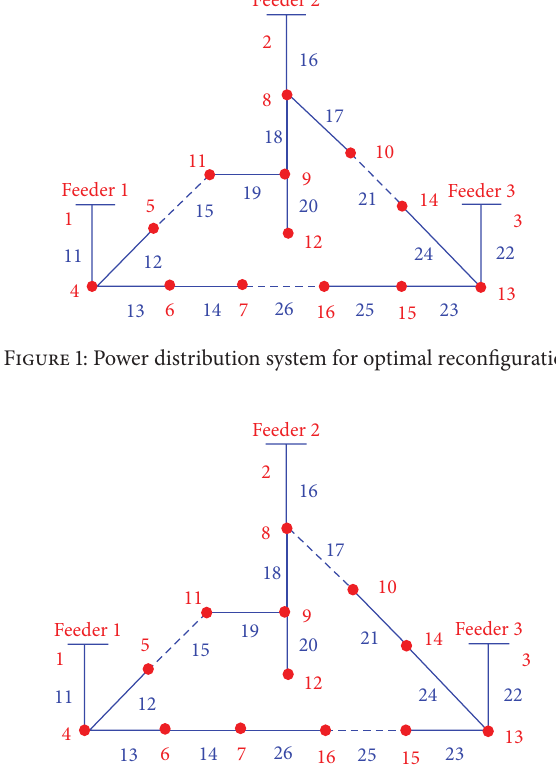
Figure 2: New configuration for the distribution